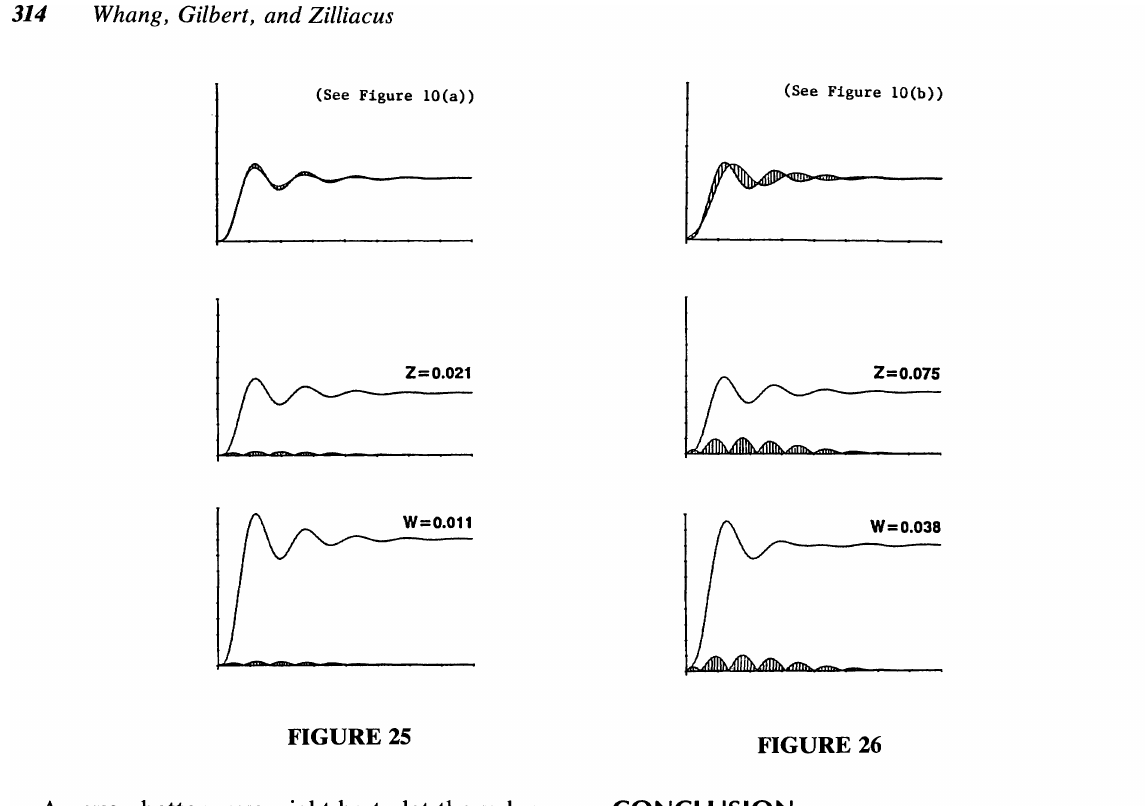
CONCLUSION Two visually meaningful correlation measures have been proposed for comparing calculated and measured response histories: Zilliacus' error index and Whang's inequality index. The